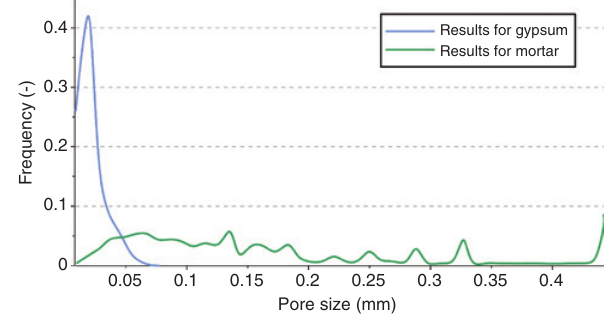
Figure 10: Pore size distribution.